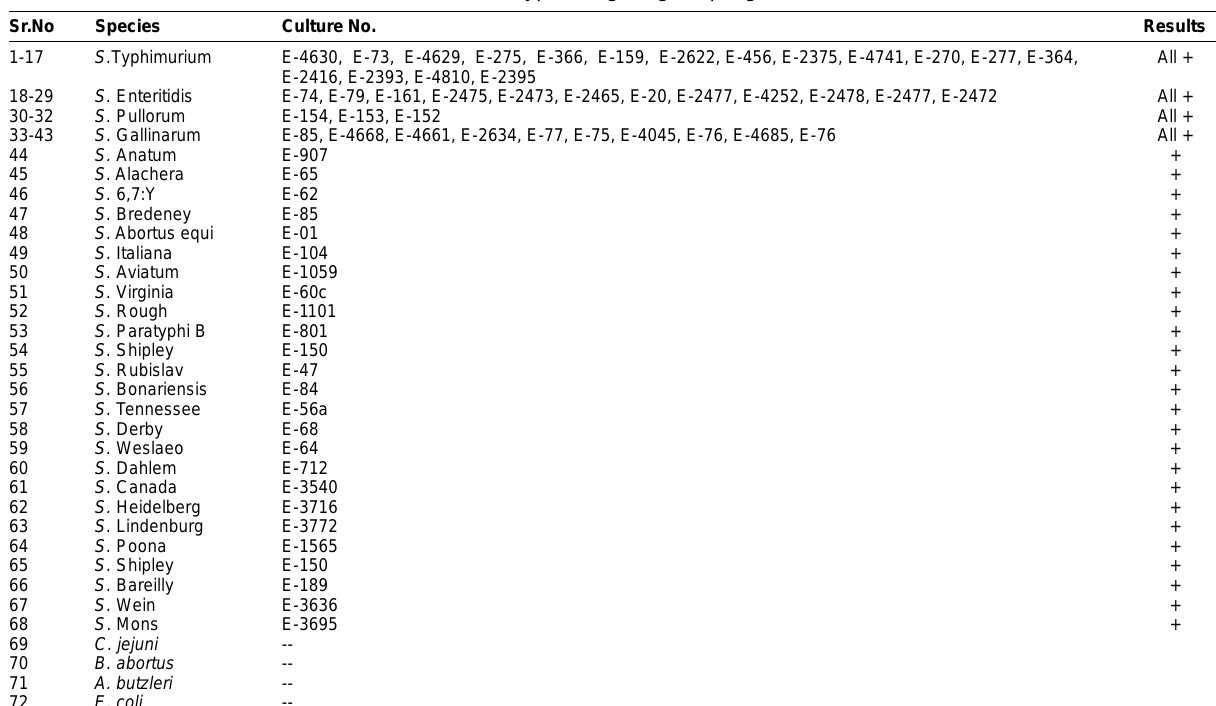
Table-1. PCR results for different Salmonella serotypes targeting OmpA